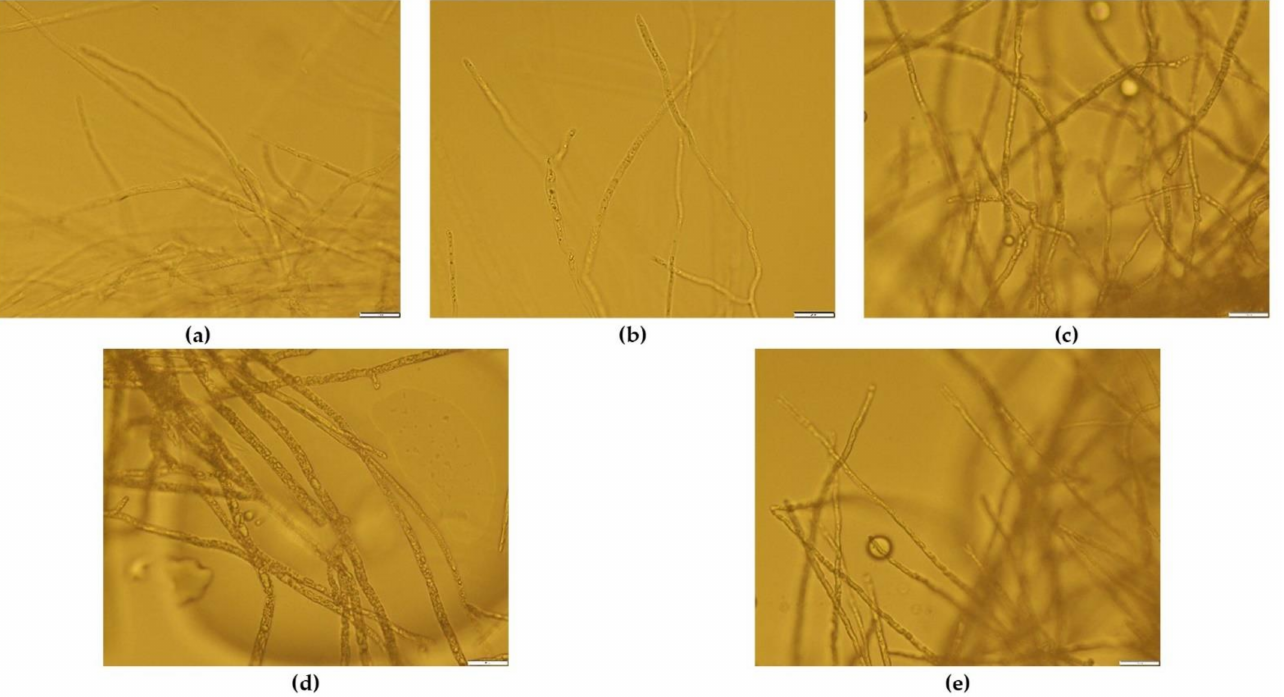
Figure 2. Morphology of F. graminearum hyphae under light microscope (magnification × 400) treated with cinnamon EO: ( a ) Control; ( b ) EO concentration 0.1%; ( c ) EO concentration 1.0%; ( d ) EO concentration 5.0%; ( e ) EO concentration